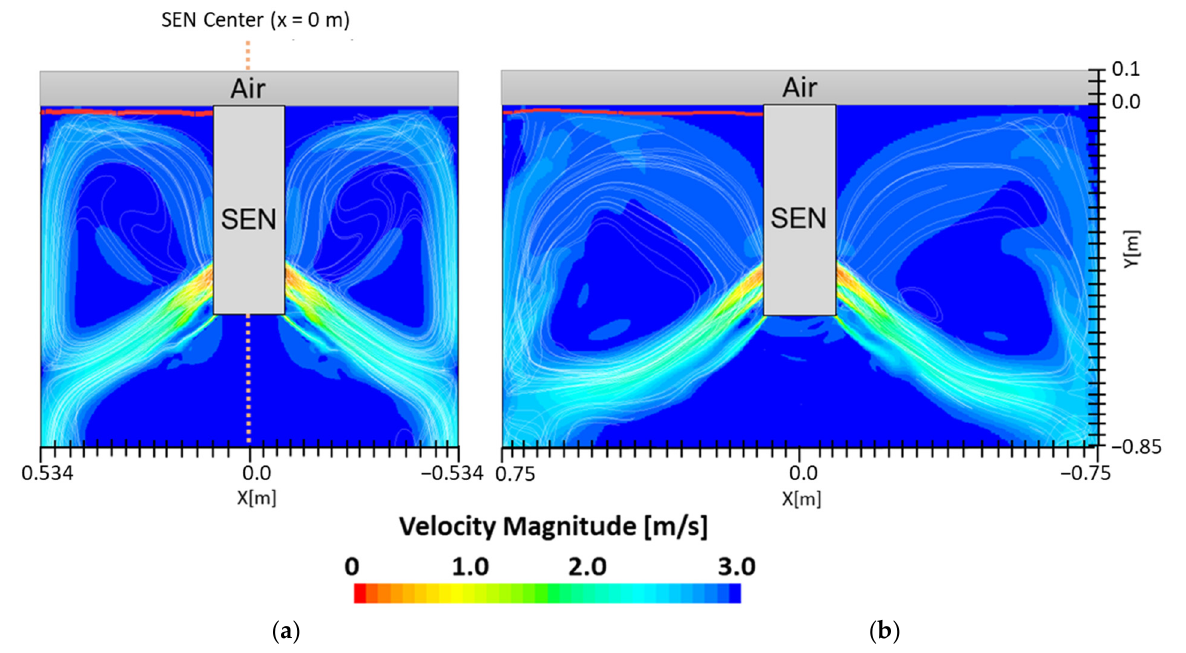
Figure 17. ( a ) Low mold width 1.067 m (Case 5) vs. ( b ) high mold width 1.50 m (Case 7) flow streamline.